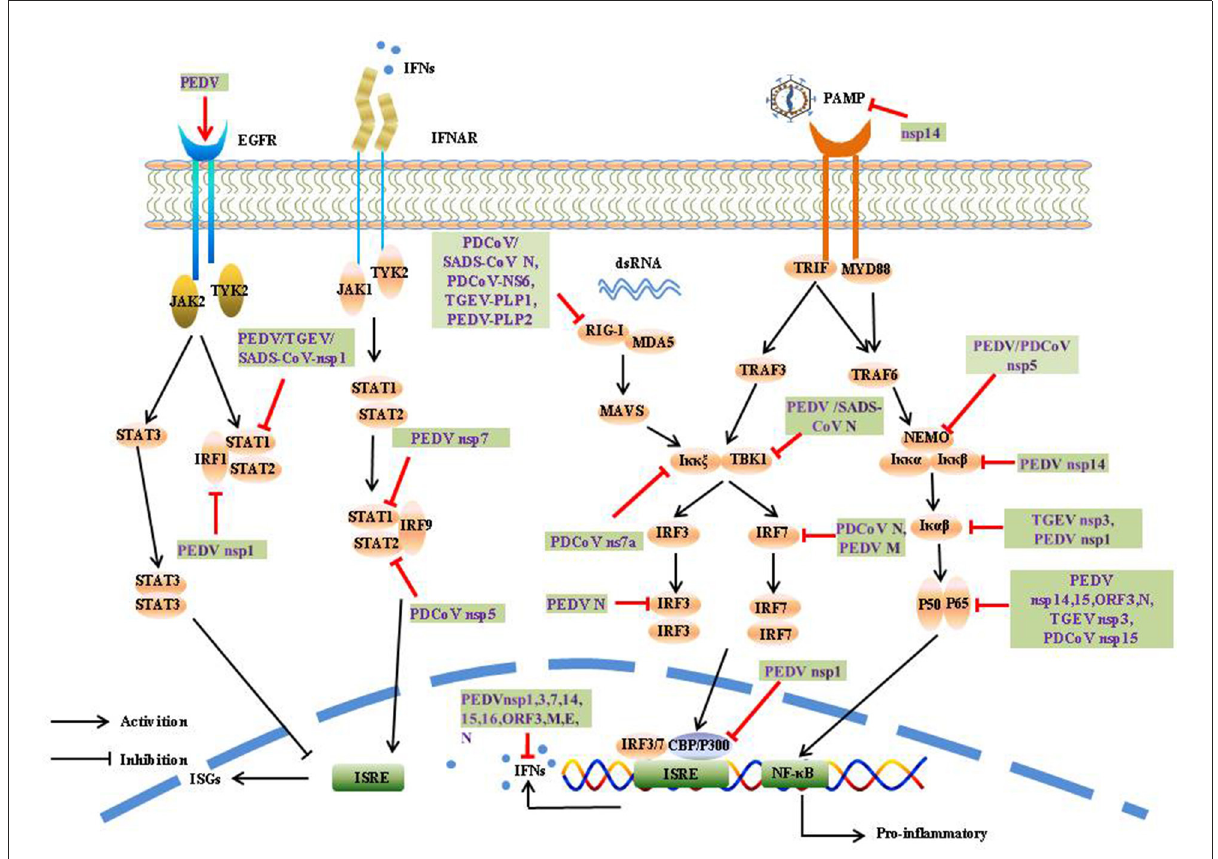
FIGURE4 Innate immunity and modulatory mechanisms during SeCoV